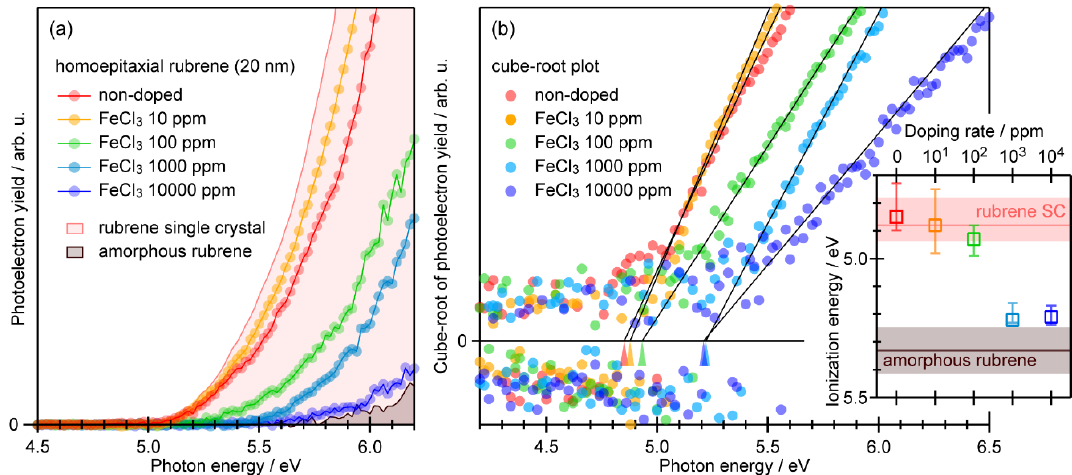
Figure 3. (a) PYS spectra of 20-nm-thick homoepitaxial rubrene overlayers of various doping ratios grown on rubrene single crystal substrates. PYS spectra of a single crystal sample and an amorphous film of rubrene are also displayed as hatched areas. (b) PYS spectra plotted in the cube-root scale of the photoelectron yield. Ionization energy positions derived from least-squares fitting of these spectra are indicated with wedge marks, where thin lines show the fitting results. (Inset) Ionization energy of rubrene overlayers plotted as a function of the doping rate. The ionization energy values for the bare rubrene single crystal (SC) and the amorphous rubrene are also indicated with pink and brown lines, respectively, where light-colored bands indicate error ranges.